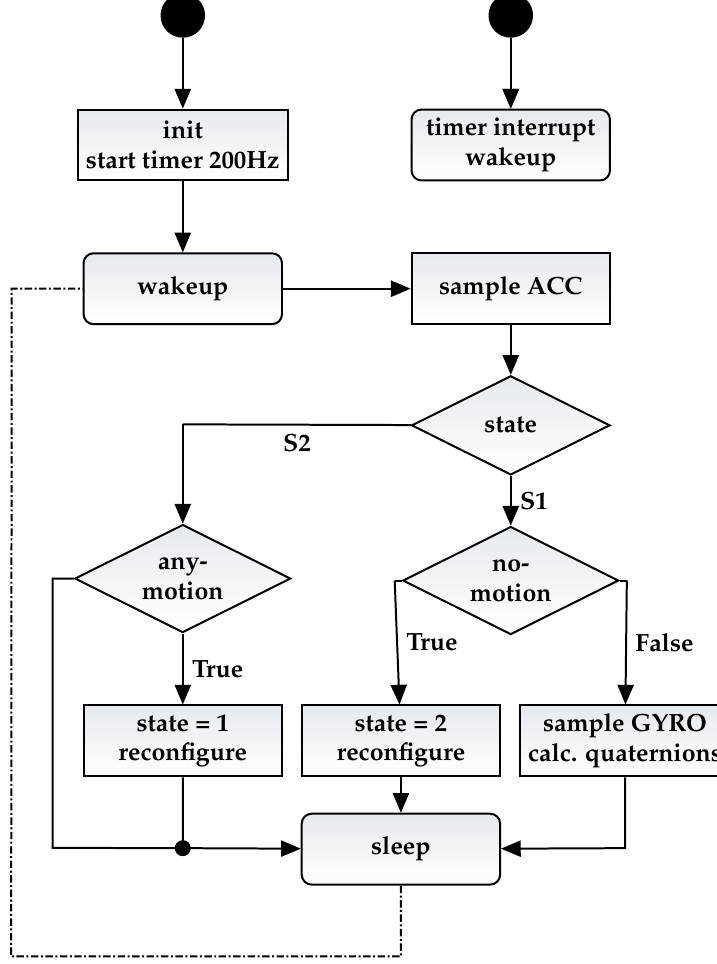
Figure 9. Control flow of complex test